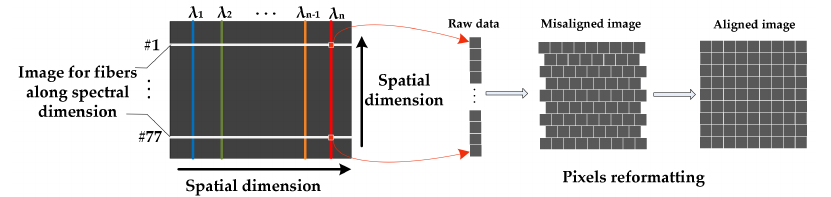
Figure 6. Schematic of a raw image of the proposed prototype.